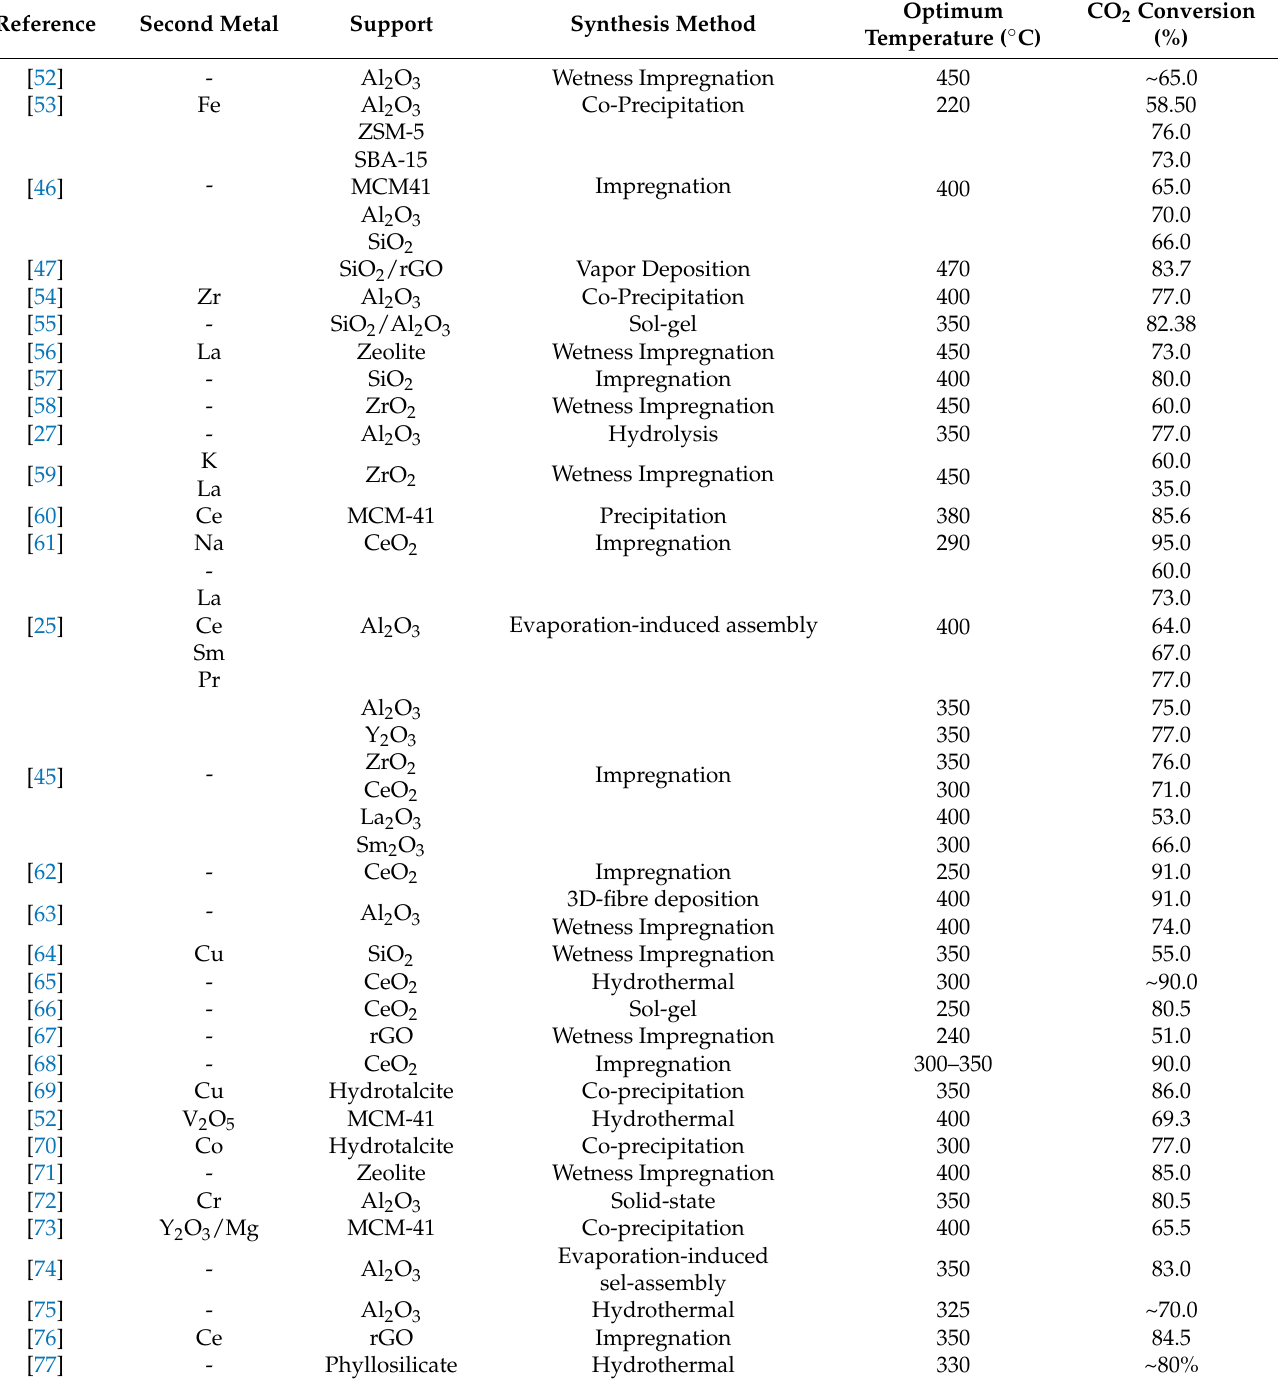
Table 2. Summary of Ni-based catalyst and its performance for CO 2